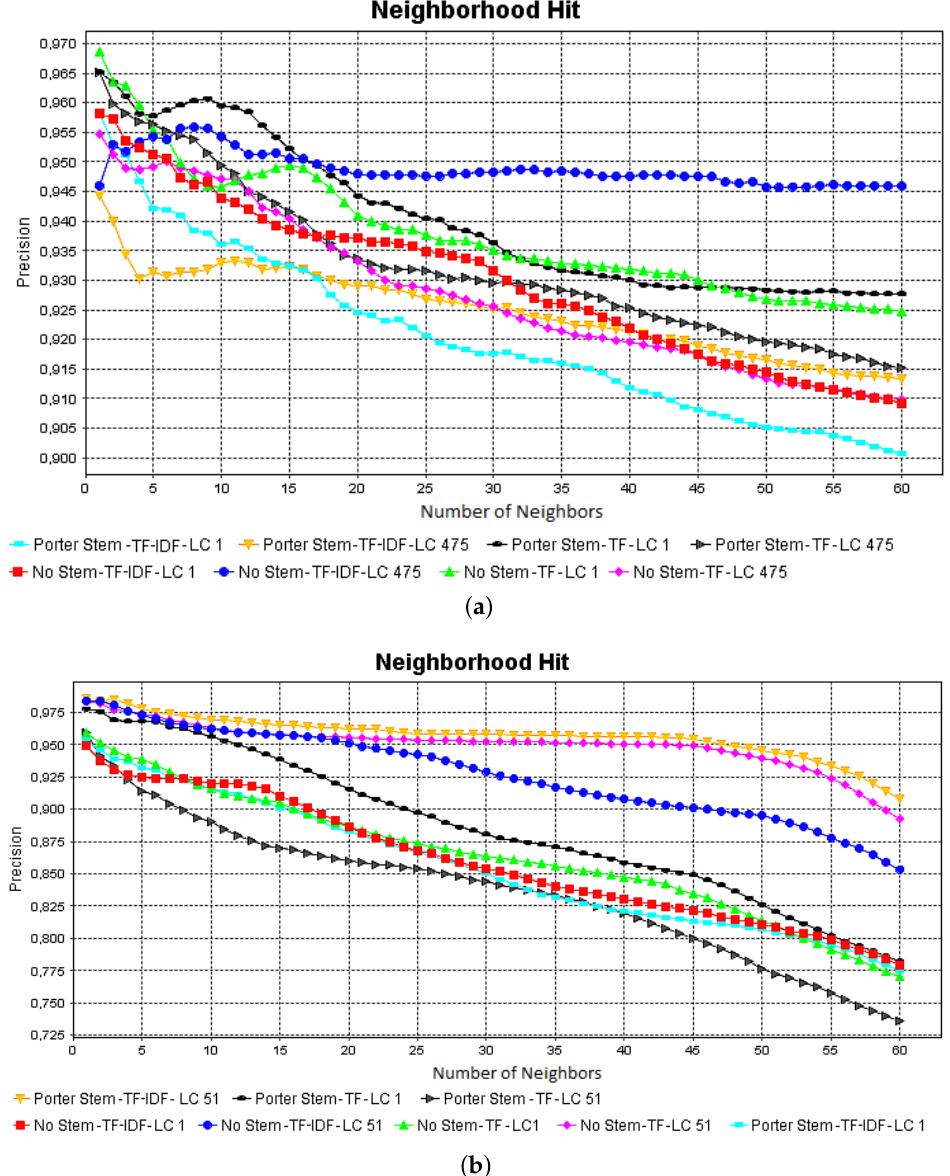
Figure 5. Neighborhood hit graphics for analyzing the quality of projections computed from vector space models generated from the CBR-ILP-IR ( a ) and NEWS-8 ( b )